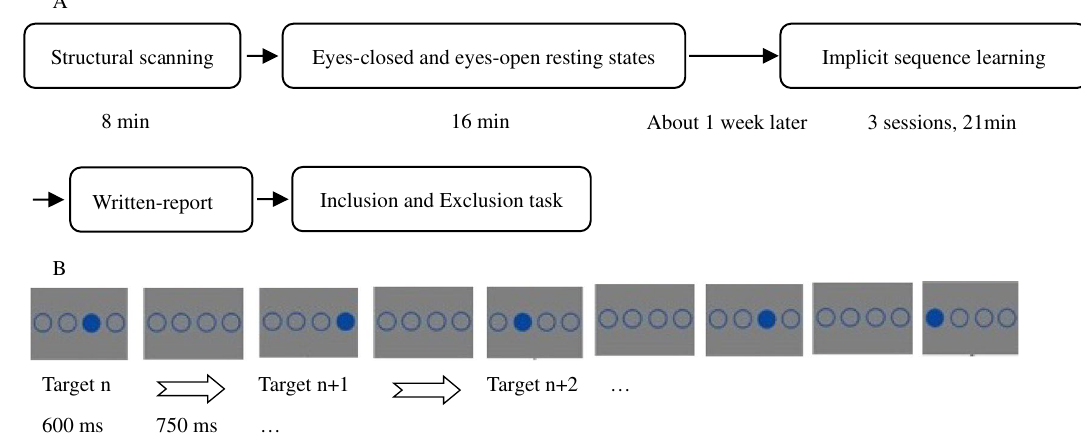
Figure 1. A, flow chart of all experiments; B, stimulus presentation of implicit sequence